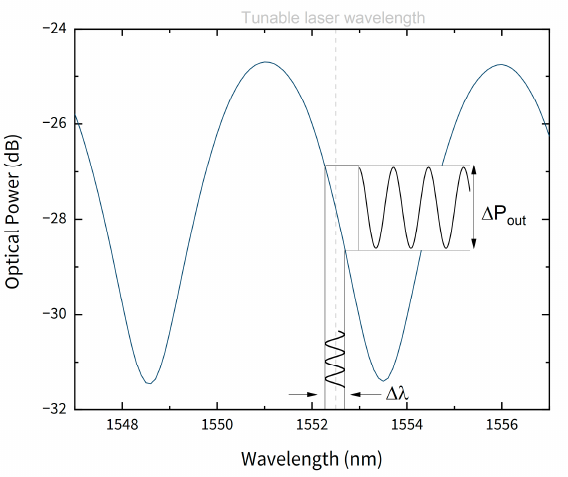
Figure 4. Reflected spectrum of the sensor. The tunable laser wavelength is marked in dashed line.